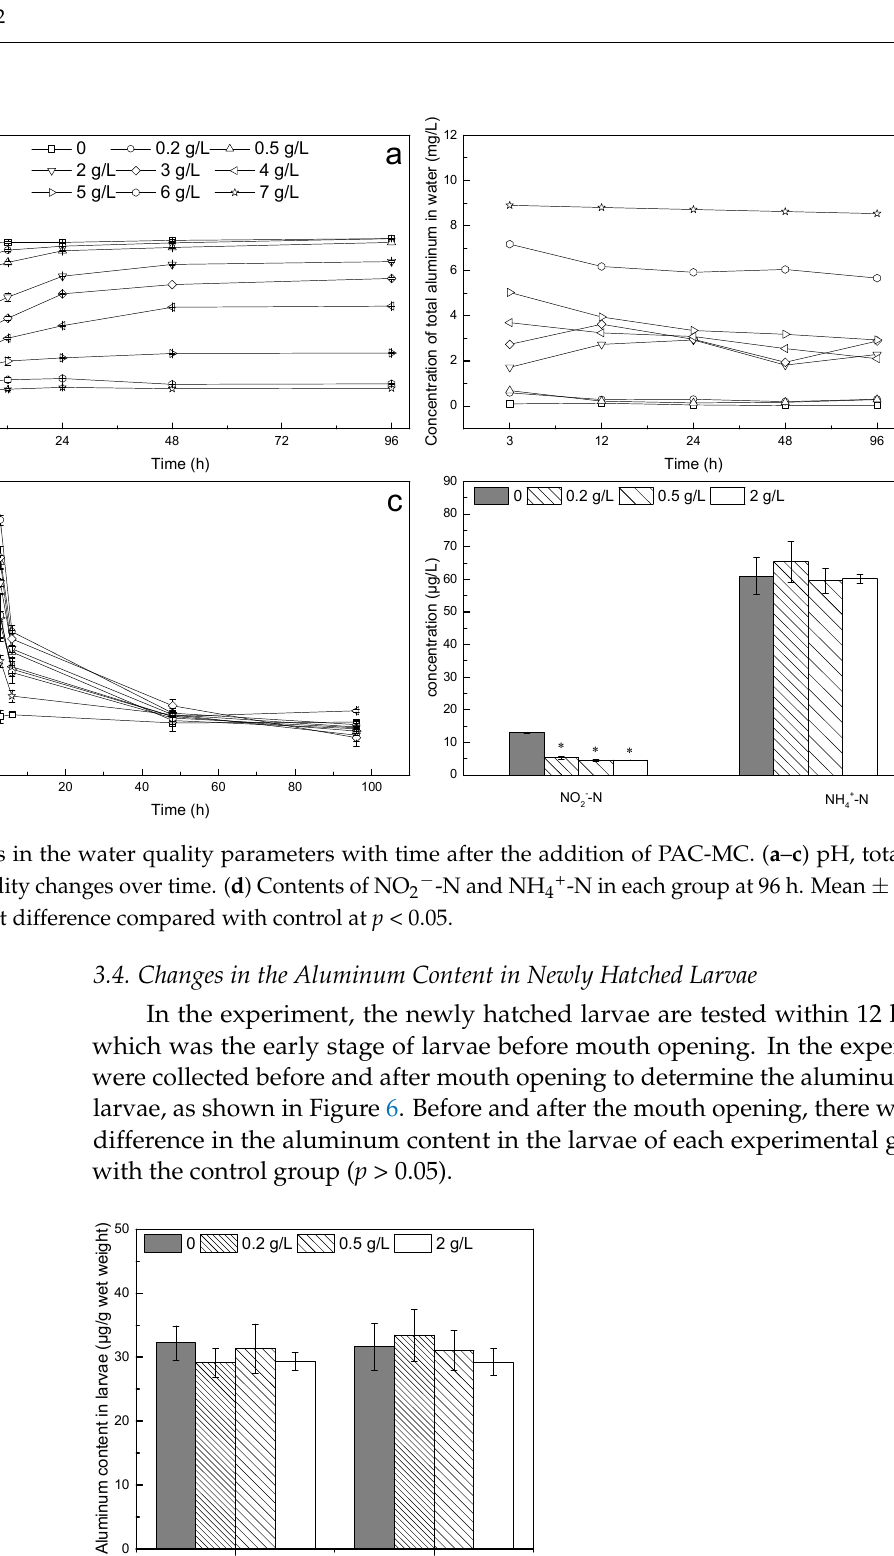
Figure 7. Particle size distribution of clay before and after PAC modification. Kaolin clay has a lamellar structure. There are many finely divided small particles on the larger particles, the surface of the particles has cracks, the whole particles have sharp edges and corners, and the interface is clear. The surface of PAC-MC is covered by colloi- dal substances, and at the same time, particles with smaller diameters are attached to the outermost layer, making the entire clay particles thicker (Figure 8). It can also be seen from the figure that the particle size of PAC-MC is generally larger than that of kaolin clay.